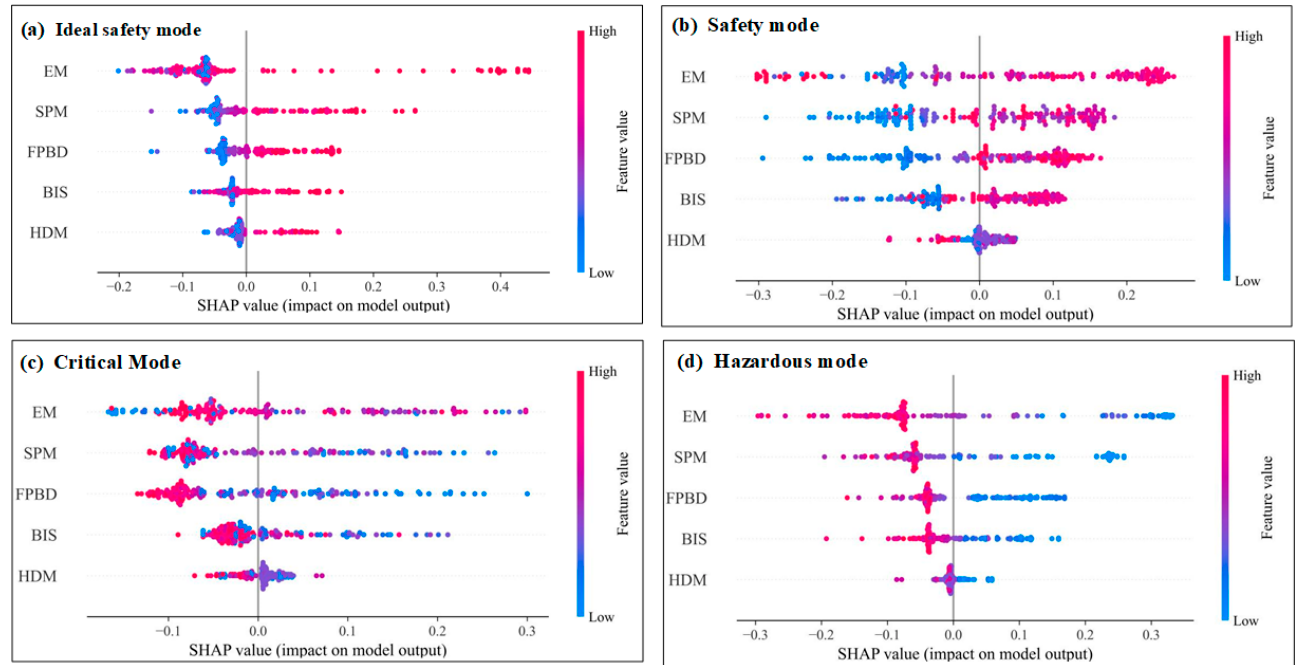
Figure 6. Summary plots for various assessment mode of fire risk.